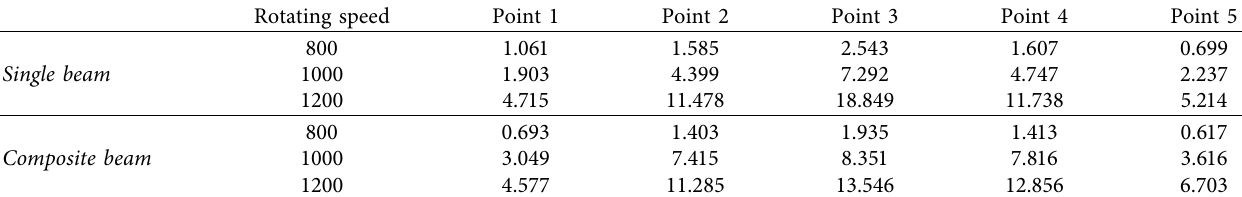
Table 1: Acceleration amplitude of each measuring point of the single beam/composite beam structure.